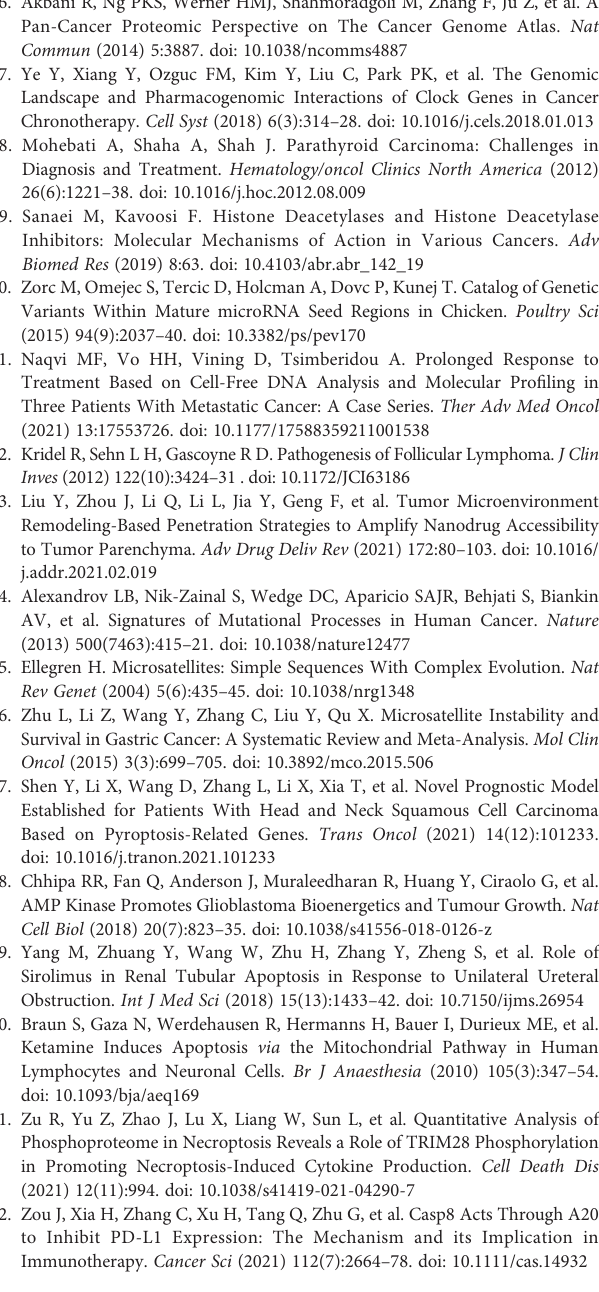
Supplementary Figure 9 | GSVA score in selected cancer types. Supplementary Figure 10 | GSVA score in stages of selected cancer types. Supplementary Figure 11 | Survival between high and low GSVA score groups. The color represents the hazard ratio (HR), and the size represents the P-value. Supplementary Figure 12 | Enrichment scores of gene set in the selected cancers.